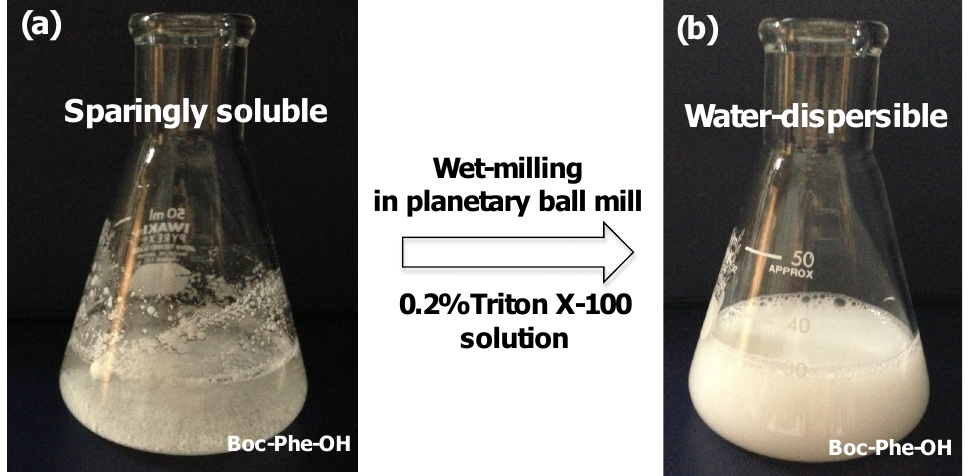
Figure 2. Wet-milling in planetary ball mill ( a ) Photo image of unprocessed Boc-Phe-OH; ( b ) Photo image of water-dispersible Boc-Phe-OH